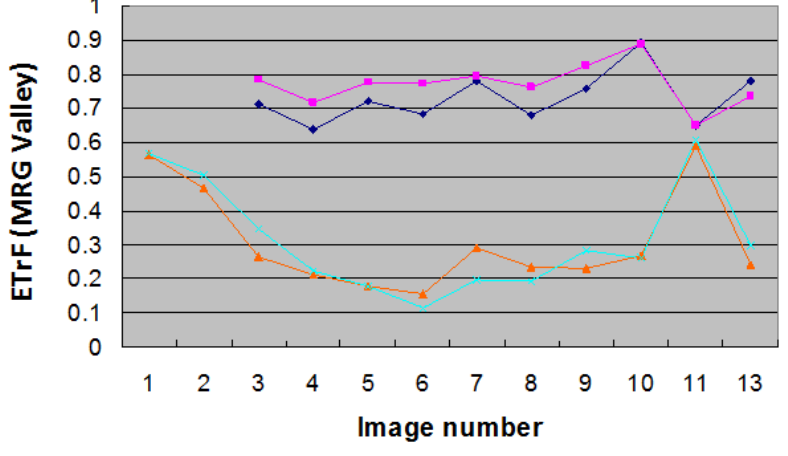
Figure 14. MODIS and Landsat based average ET or higher) and low vegetation (NDVI = 0.20 and lower) pixels in MRG, analyzed at 500 m